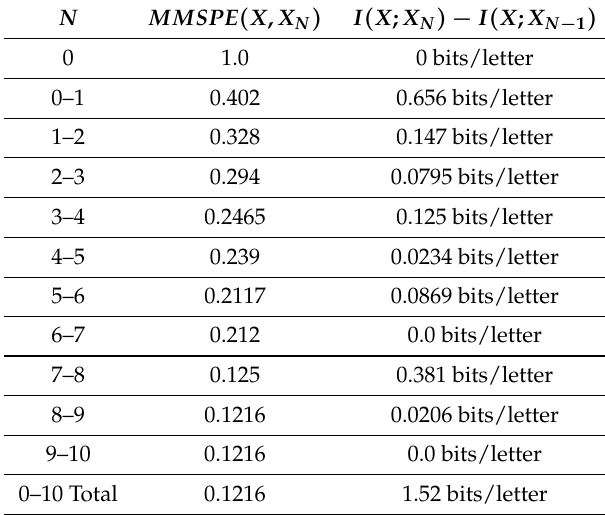
Table 1. Change in mutual information from Equation (17) as the predictor order is increased: Frame 3237, SPER = 9.15 dB; MMSPE, minimum mean squared prediction